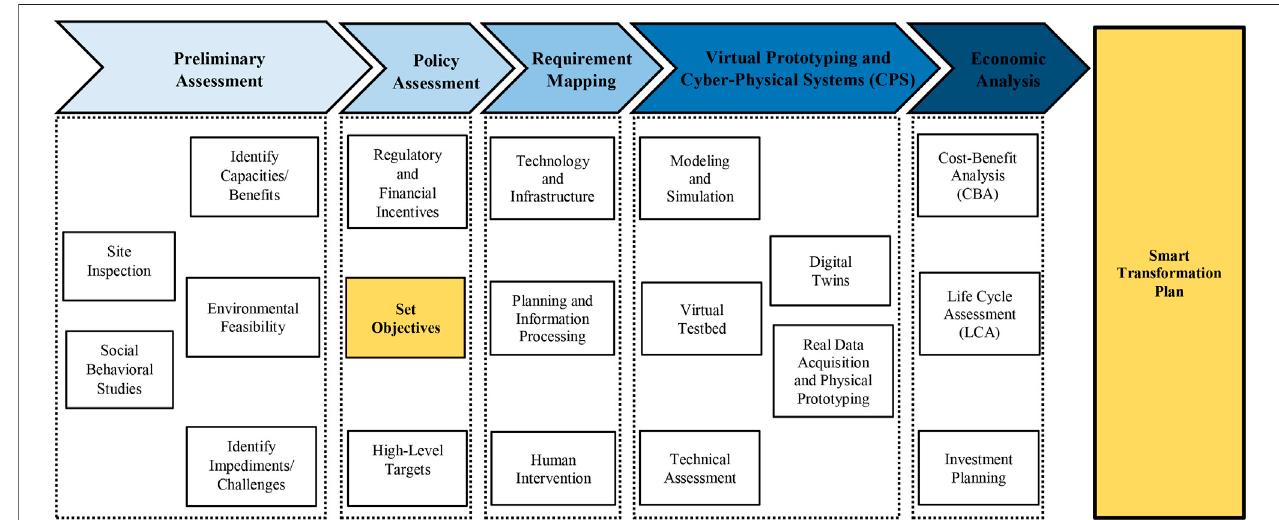
FIGURE 2 | Strategic framework and multiple decision-making stages to establish a smart transformation plan.